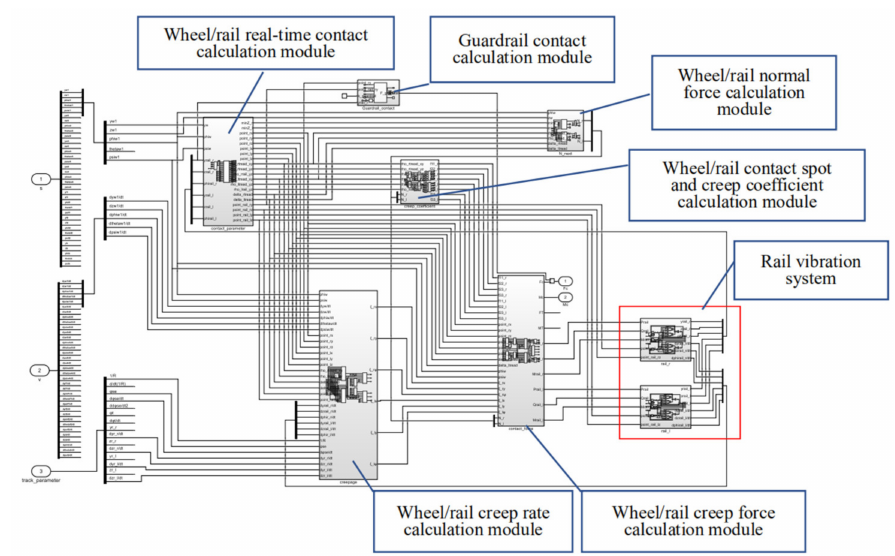
Figure 6. Wheel/rail interaction calculation module based on